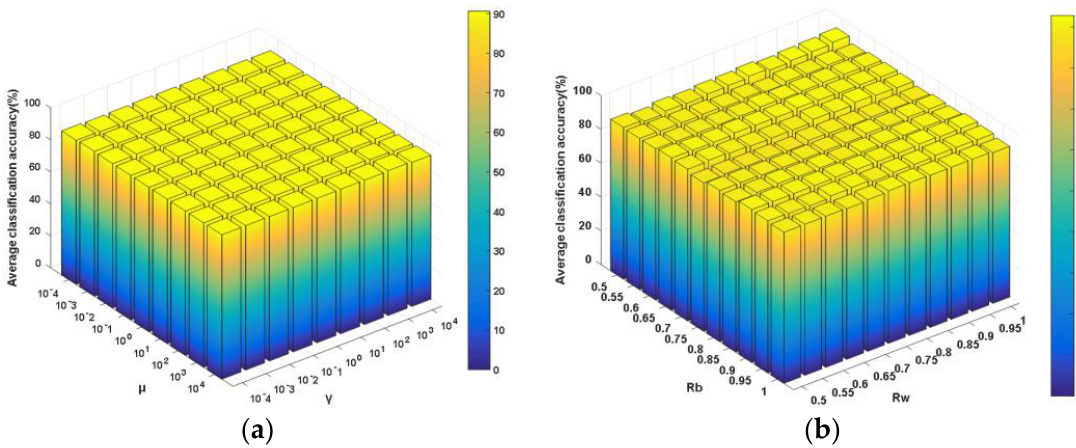
Figure 11. NN plus NDCA performance under different combinations of parameters. ( a ) μ and γ ( best : 90.60%; worst : 89.76%); ( b ) Rb and Rw ( best : 92.81%; worst : 87.82%).